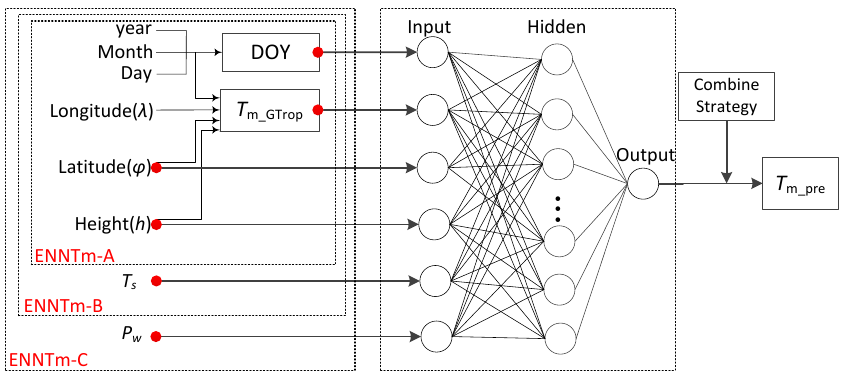
Figure 2. The model structures of three different modeling schemes. The red solid circles denote the direct input parameter of BPNN